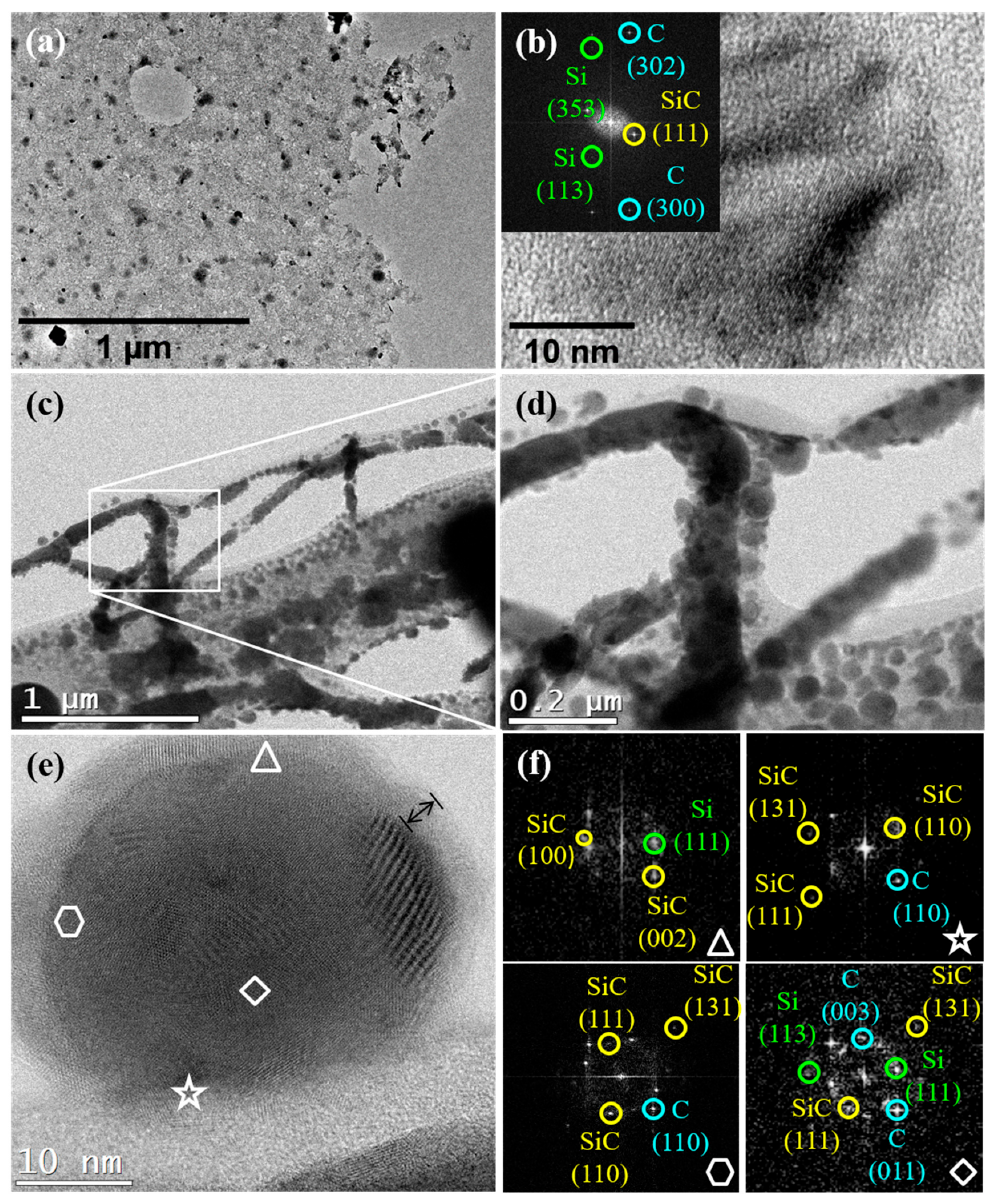
Figure 4. TEM and HR-TEM images of the sample A ( a , b ) and the sample B ( c – e ) after thermal annealing of GO at 1000 °C. ( a ) rGO sheets decorated by Si-based polydispersed nanoparticles. ( b ) HR-TEM of an irregularly shaped nanoparticle, where the inset corresponds to the FTT of ( b ). ( c , d ) Images of carbon–silicon-based nanowires (CSNW) which consist of Si-based nanoparticles embedded into 1D self-assembled rGO sheets. ( e ) HR-TEM of a nanoparticle, where it can be observed that it is polycrystalline. ( f ) The FTT of selected areas in ( e ).